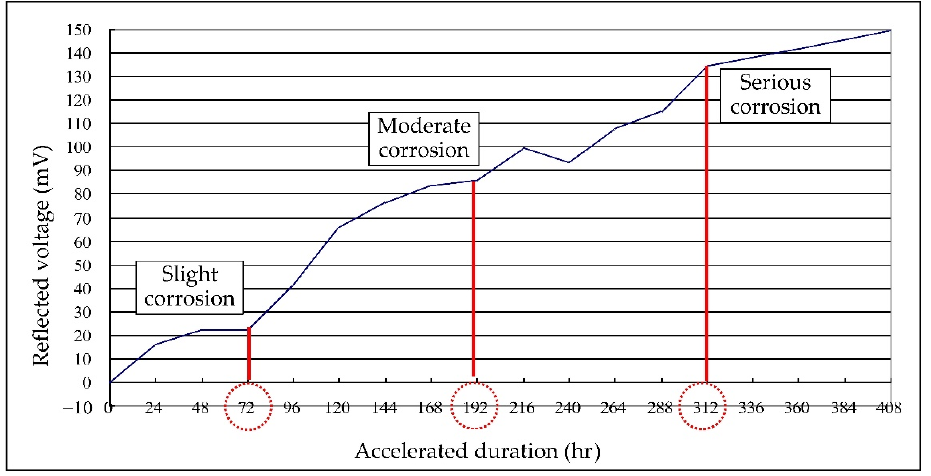
Figure 13. Reflected Voltage of 4 cm Protective Layer.